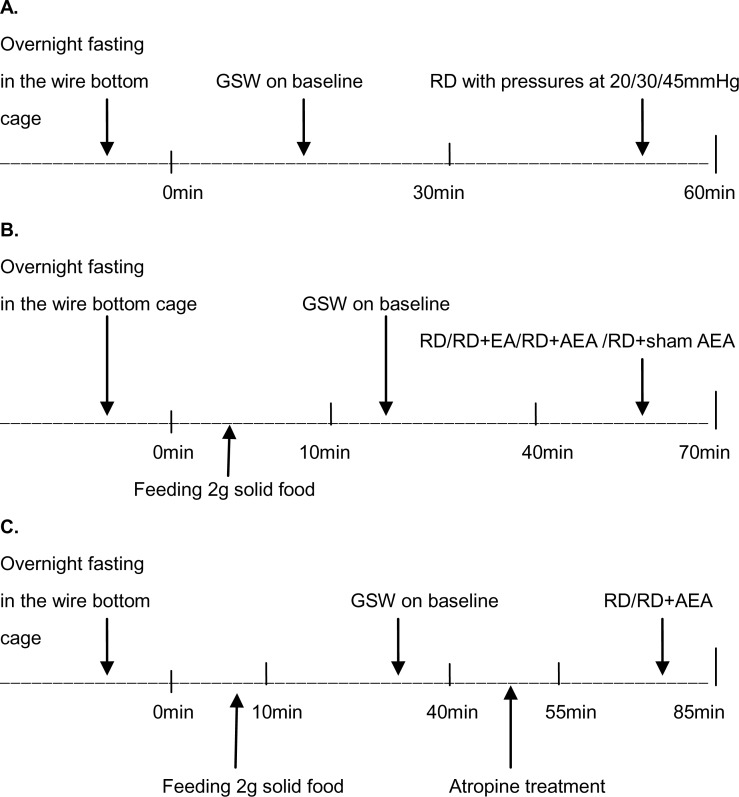
Experimental protocol.(A) GSW recordings in the fasting state at baseline and during RD; (B) GSW recordings in the fed state before and during RD or RD plus EA/AEA/sham-AEA; (C) GSW recordings in the fed state before RD and during RD at presence of atropine.